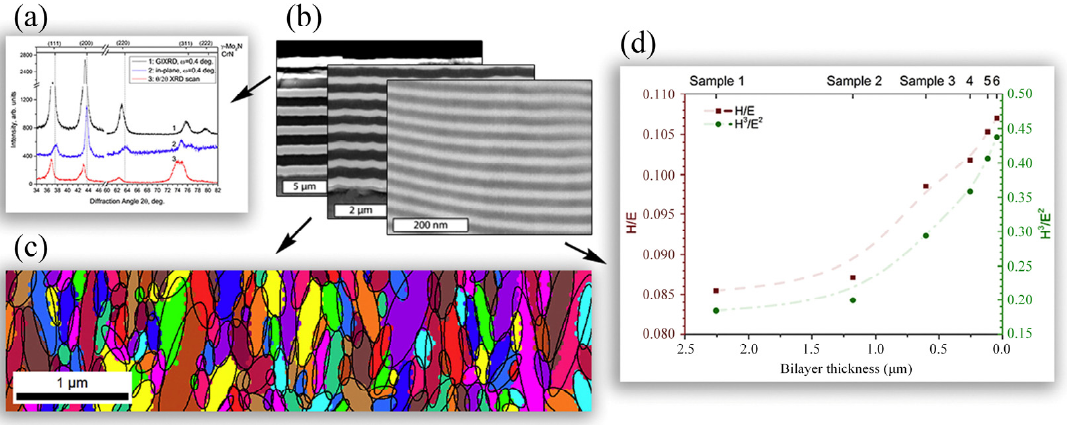
Figure 3. Multilayer designing of CrN/MoN coatings. ( a ) XRD results and ( b ) cross-section images of CrN/MoN coatings with different layer thicknesses; ( c ) EBSD results of a CrN/MoN coating; ( d ) mechanical behavior of CrN/MoN coatings with different layer thicknesses. Reprinted with permission from [83].